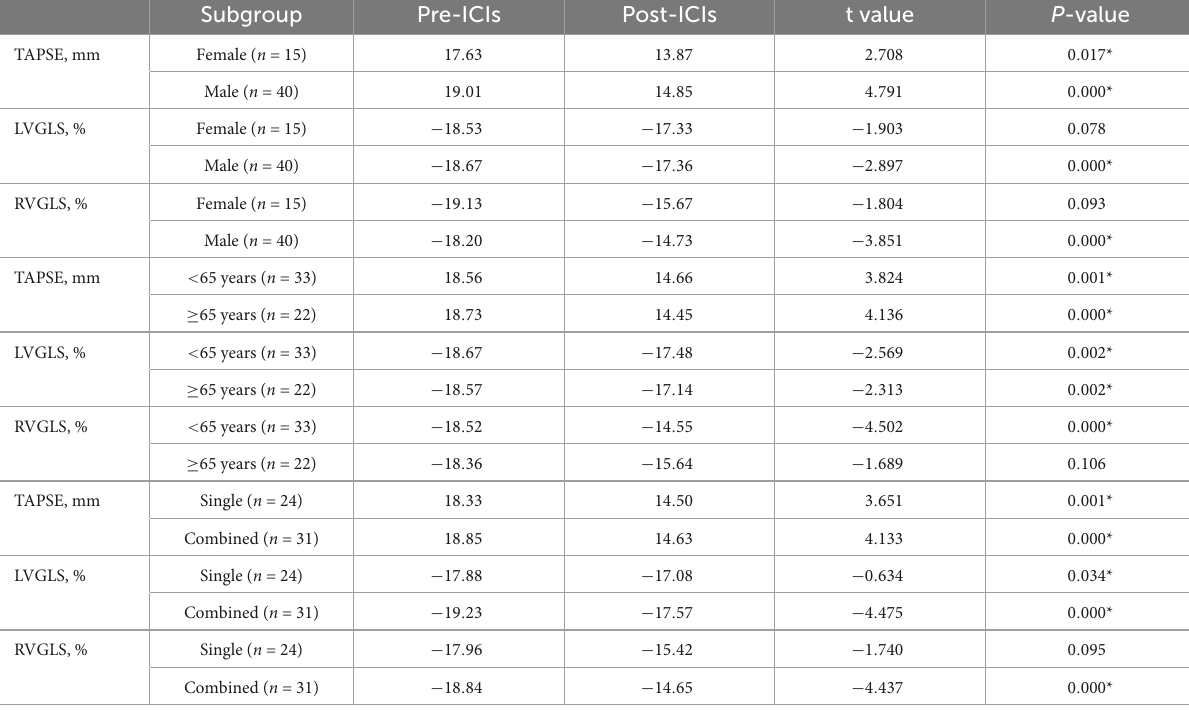
TABLE 4 Subgroup analysis of echocardiography data before and after immune checkpoint inhibitors (ICIs) treatment. Subgroup Pre-ICIs